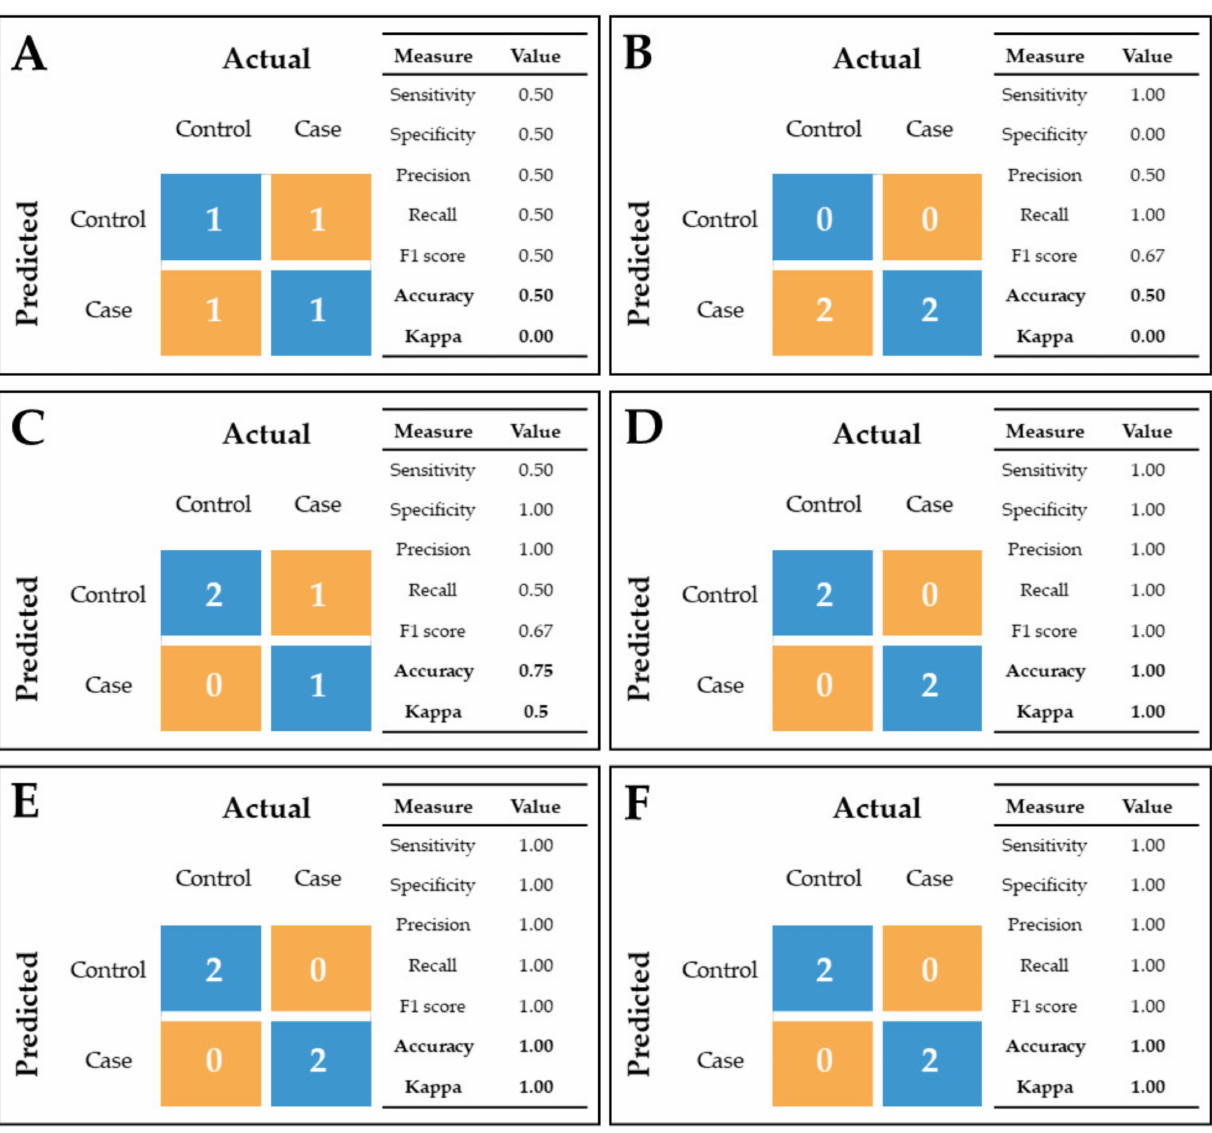
Figure 5. Performance of different classification models on test data using different algorithms and options for feature selection in the form of classification matrices: ( A ) minimal-redundancy-maximal-relevance (mRMR)–10 top-ranked features; ( B ) mRMR–20 top-ranked features; ( C ) mRMR–30 top-ranked features, ( D ) recursive feature elimination (RFE)–7 features selected; ( E ) RFE–9 features selected; ( F ) Combined mRMR (30 top-ranked features) and RFE (7 and 9 features selected)–only features in overlap in 2/3 models were used (6